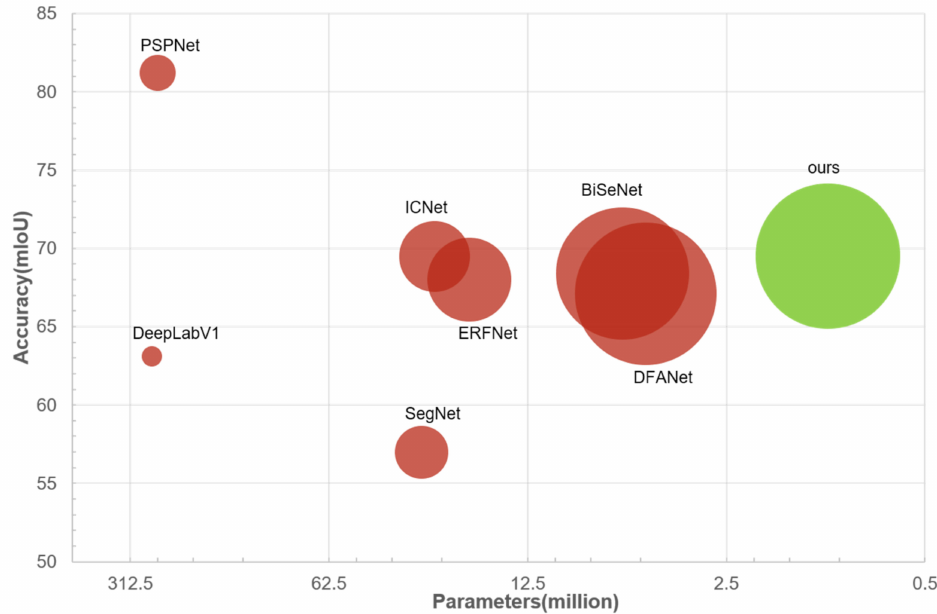
Figure 1. A comparison of the combined performance (including inference speed, accuracy, and number of parameters) among different methods. The bigger the circle, the faster the